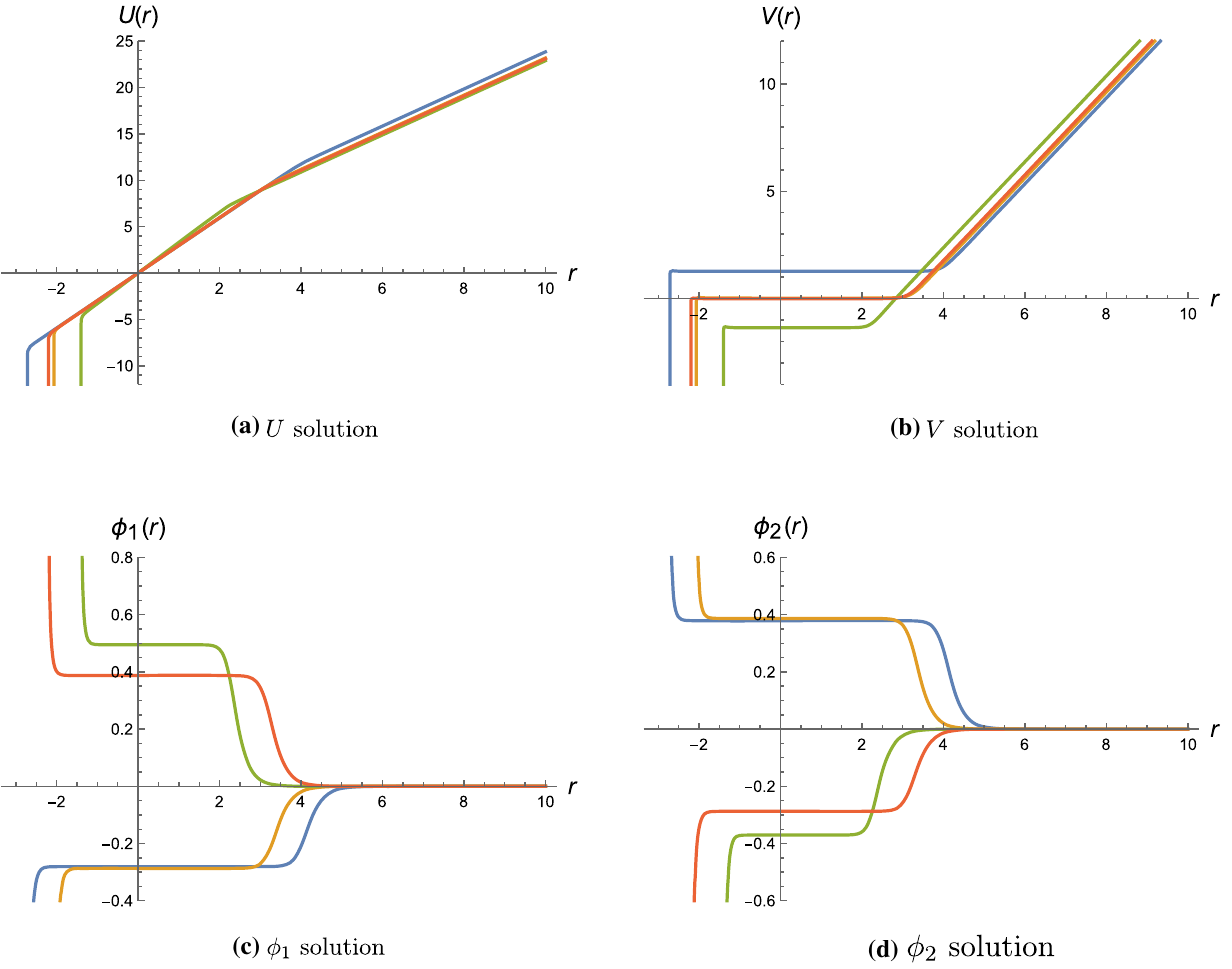
Fig. 3 RG flows from the N = 4 AdS 7 critical point as r → ∞ to AdS 5 × S 2 fixed points and curved domain walls for SO ( 2 ) × SO ( 2 ) twist in SO ( 5 ) gauge group. The blue, orange, green and red curves refer to p 2 = − 12 , − 1 , 1